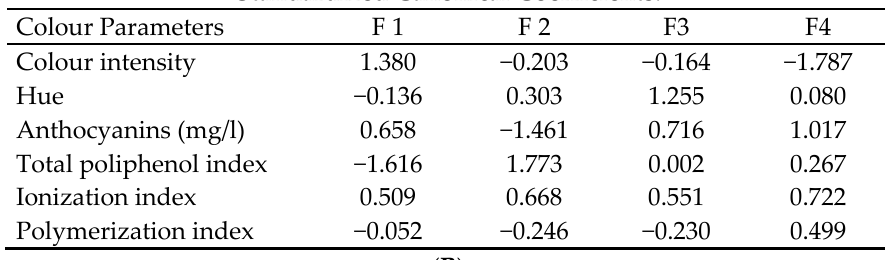
Figure 5. ( A ) Canonical discriminant graph of colour parameters in control samples (C), samples early inoculated with M. pulcherrima (M) and samples early inoculated with a mix of L. thermotolerans & T. delbrueckii (LT), after alcoholic fermentation (2.) of Tempranillo (Temp), Grenache (Gre) and Graciano (Gra). ( B ) Standardized canonical coefficients of the four main discriminant variables in functions (F1 and F2) for colour parameters.